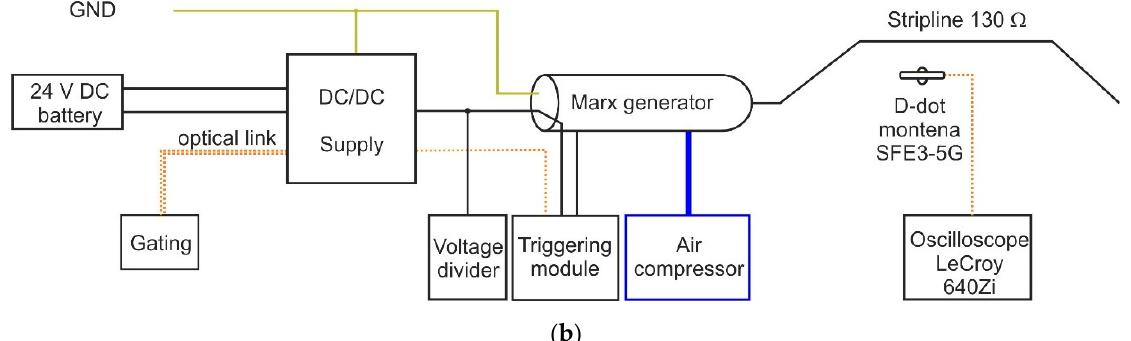
Figure 1. Scheme of the Marx generator with 20 stages ( a ) and block scheme of the whole setup ( b ).